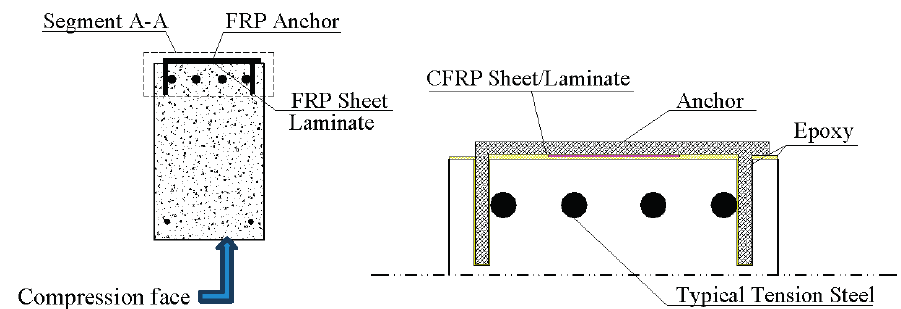
Figure 3. Details of the strengthened beam cross-section with